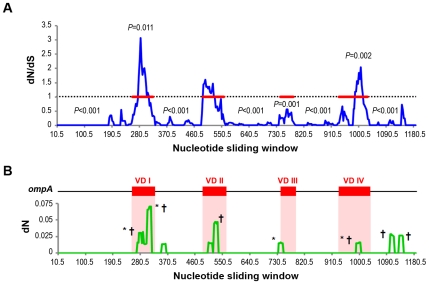
Selective pressure acting on ompA.(A) Ratio of dN/dS throughout ompA. dN/dS was estimated over a nucleotide sliding window (window size = 15; step size = 3), considering the 234 types of genetic variants and the 17 prototype strains. VDs are shown in horizontal red lines, while dashed line represents the traditional cut-off for neutral evolution. Only P-values showing statistical significance are shown. For positive and purifying selection P-values are displayed above and below the cut-off dashed line, respectively. Region containing MOMP CDIV species-specific cluster of five CTL and six Th epitopes (see text) is marked with (*). (B) dN values throughout ompA for genotype A (here, as an example). Calculations were performed over a sliding window (window size = 15; step size = 3), considering all types of genetic variants of genotype A. VDs (red boxes) display a global nonsynonymous rate 4.3-fold higher than that of the CDs (P<10−12). dN peaks involving mutations occurring within/adjacent to B-cell epitopes and/or mutations that are likely at fixation in this genotype are marked with (*) and (†), respectively.